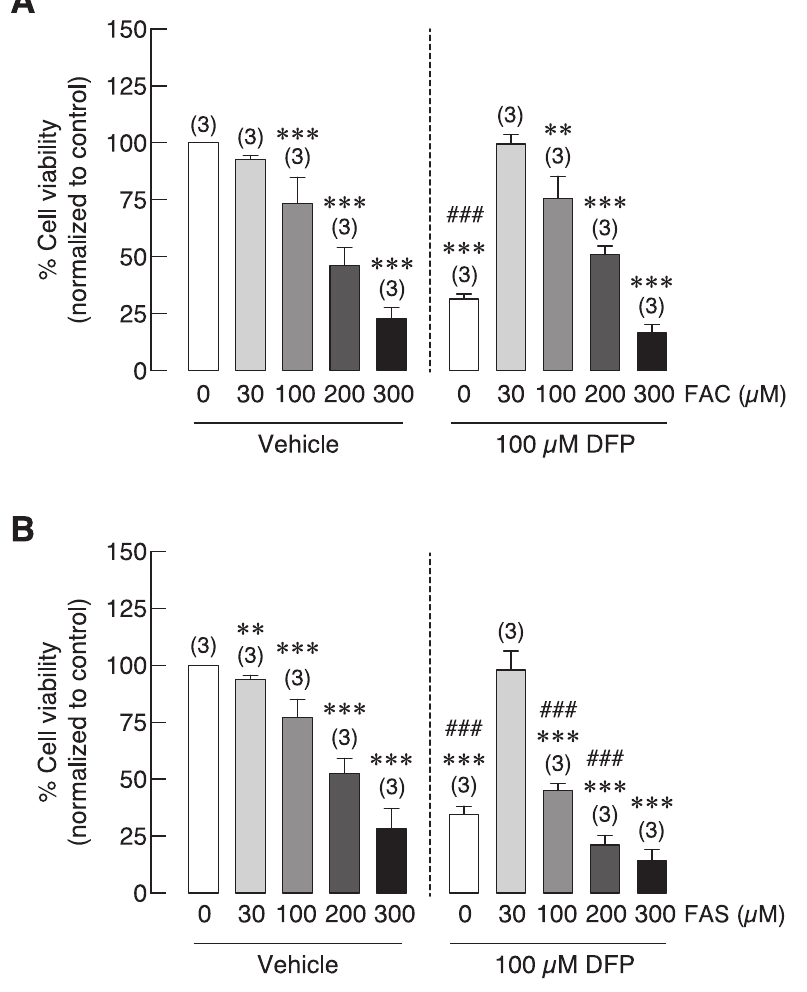
Fig 6. Osteoblast cell viability under iron overload from (A) FAC and (B) FAS in the presence of deferiprone (DFP). DFP could not recover iron-induced osteoblast cell death in both FAC and FAS treated groups. �� P < 0.01 ��� P < 0.001 as compared to control group (0 μ M) without DFP. ### P < 0.001 as compared to the same iron concentration.